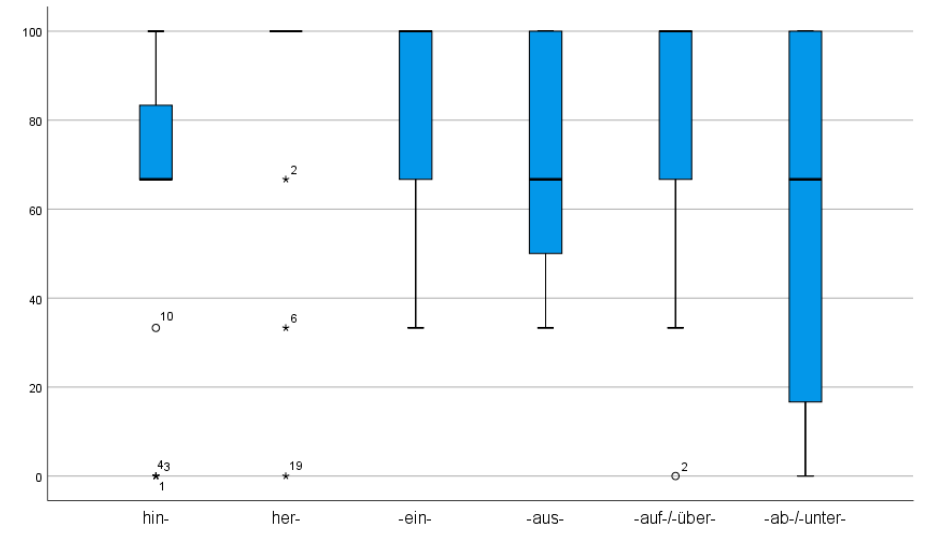
Figure 11. Boxplot: Results of the interpretation posttest per subcondition.